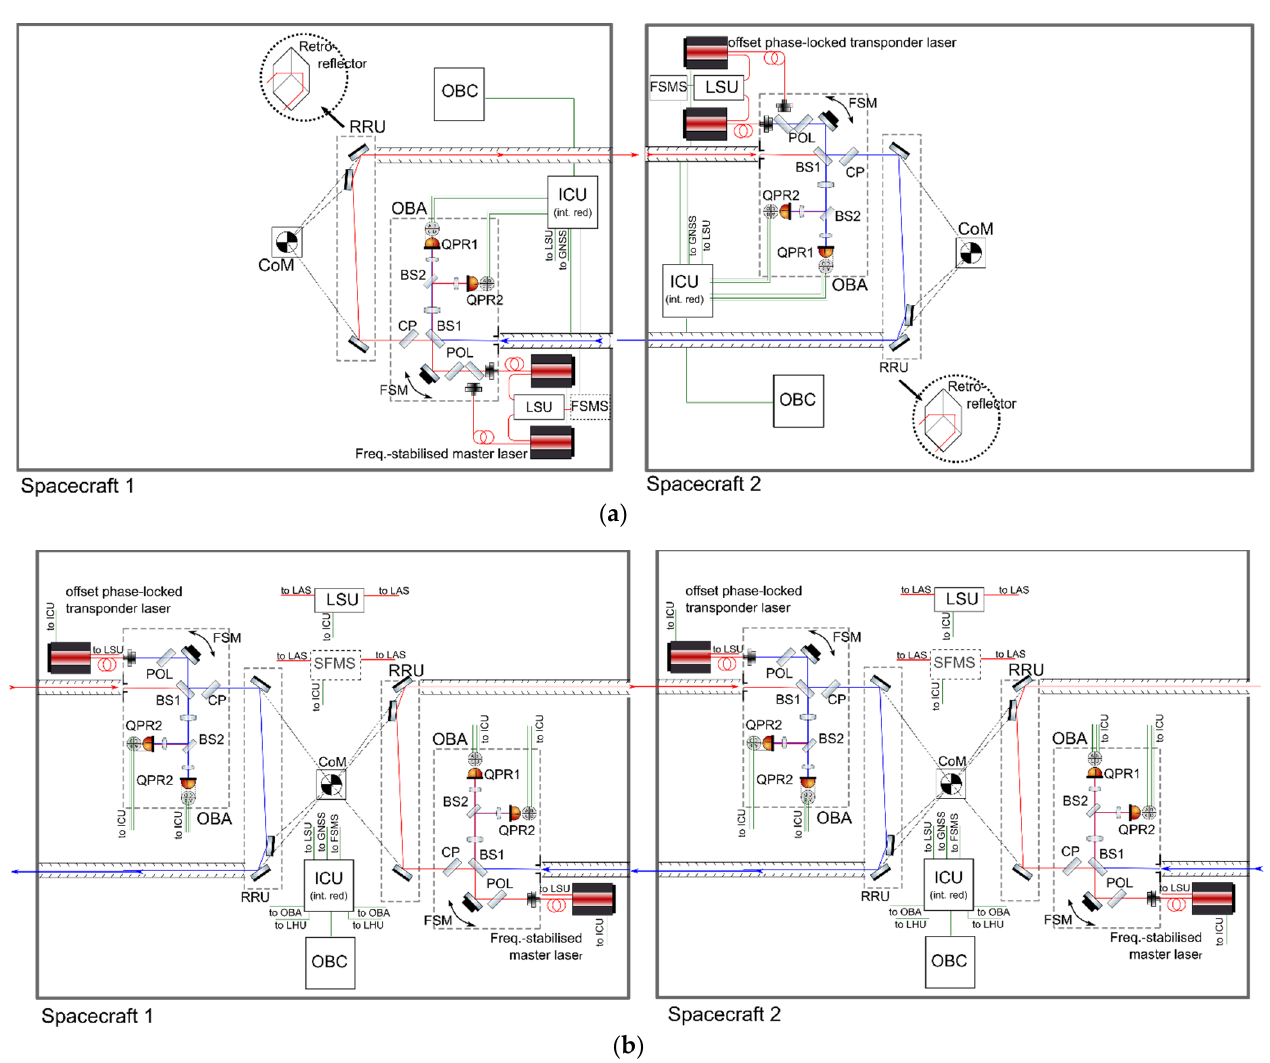
Figure 2. Concept sketch of the laser tracking instrument in off-axis transponder configuration: ( a ) with partial redundancy; ( b ) with full redundancy. ( a ) with partial redundancy; ( b ) with full